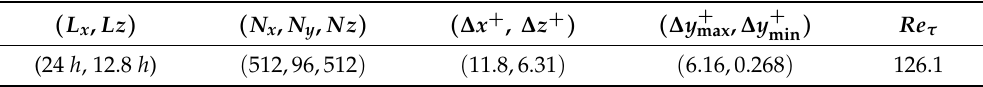
Table 1. Computational conditions: streamwise and spanwise domain lengths, number of grid points, spatial resolutions, and the friction Reynolds number Re τ = u τ δ / ν ( u τ = The Reynolds number and Prandtl number are Re w = 8600 and Pr = 0.71,